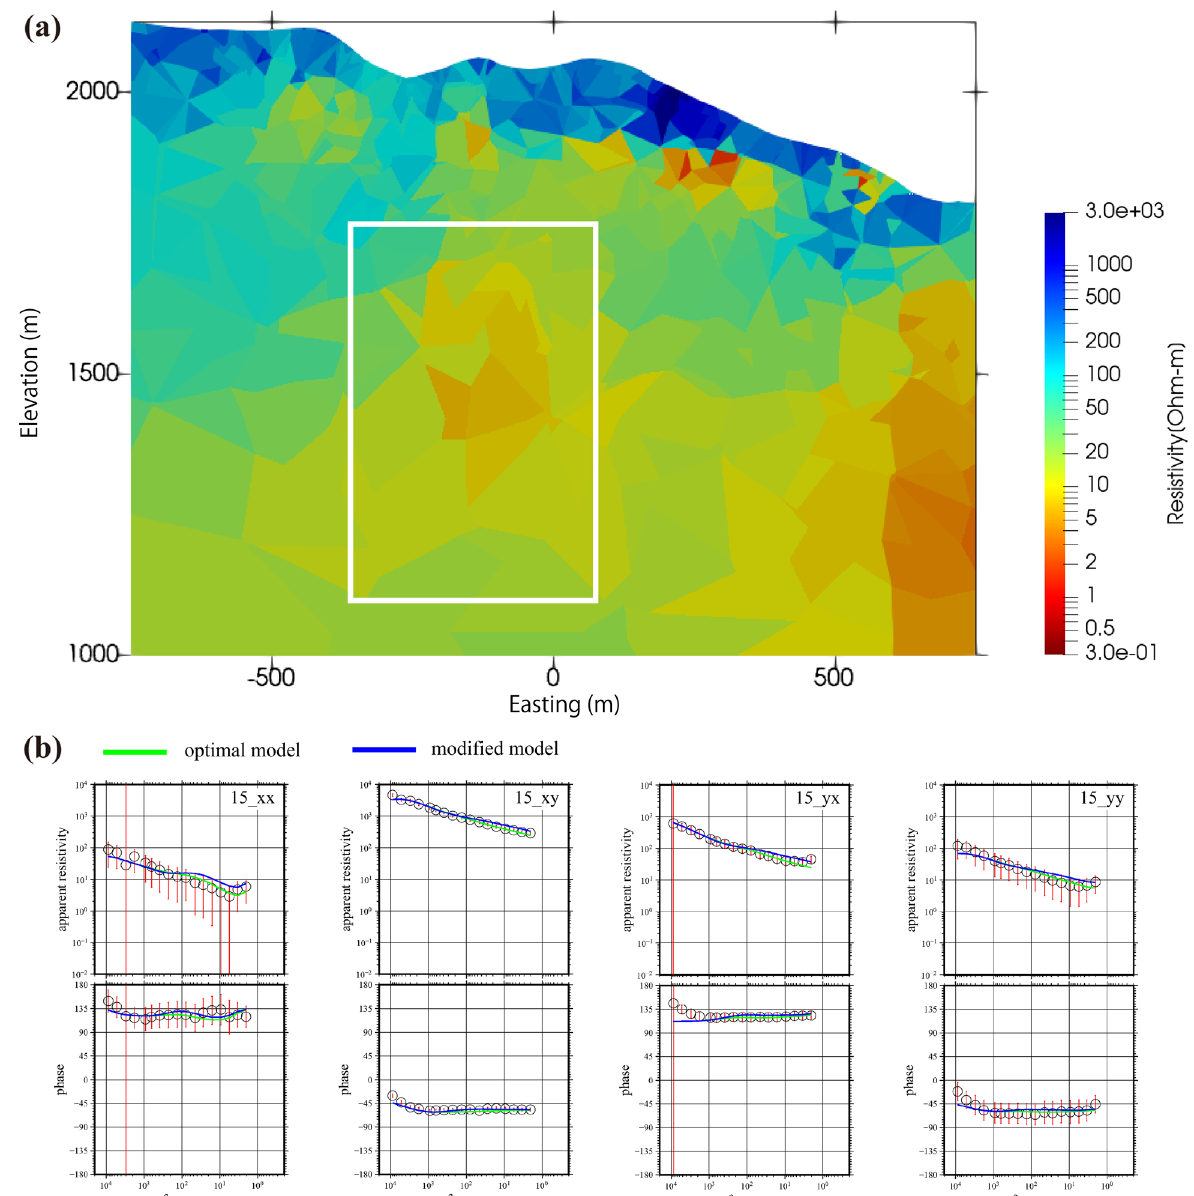
Fig. 7 Sensitivity test of the optimal 3-D resistivity structure model. a The east–west vertical cross-section through the Kagamiike-kita Crater of the optimal model is shown. The sensitivity of the region surrounded by the white solid line was tested. The size of the modified region was 0.6 km (N-S) by 0.5 km (E-W) by 0.6 km (vertical). b Sounding curves (apparent resistivity and phase) obtained from the optimal model (green), modified model (blue), and observed data (open circles with red error bars) at Site 15 directly above the modified region are